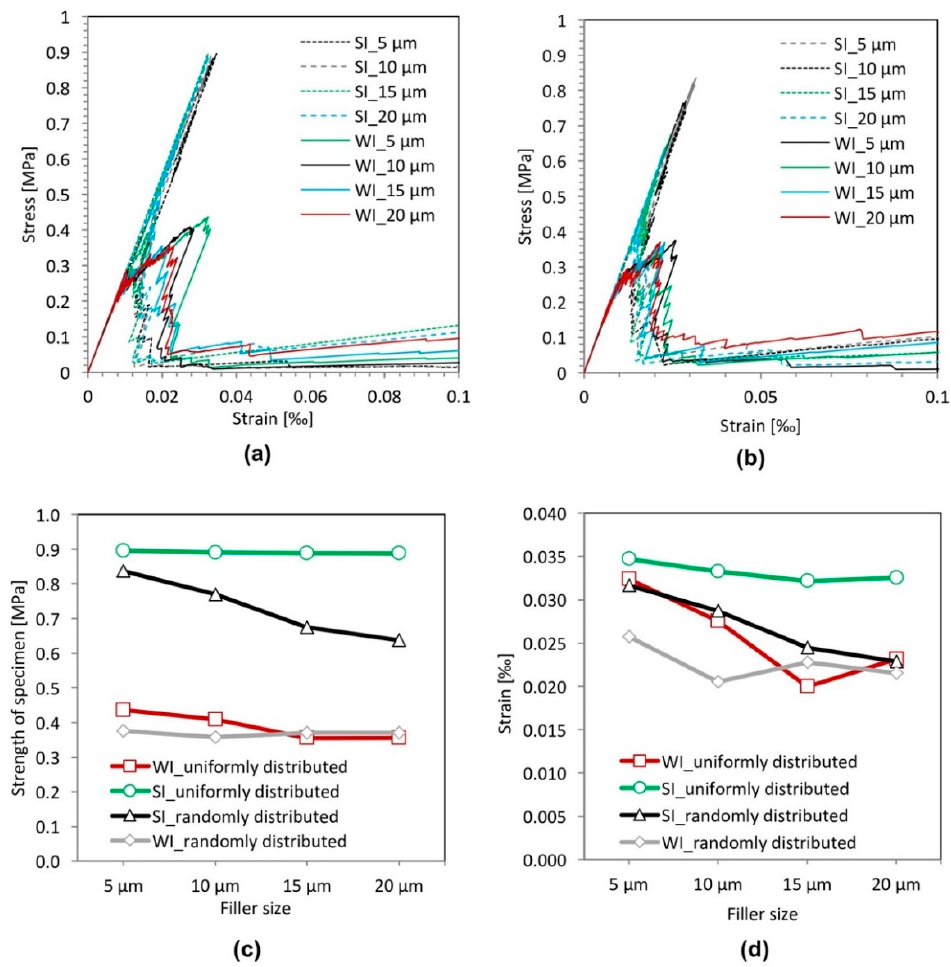
Figure 8. Simulated results of the filler size effect analyses for specimens with a strong interface (SI) and a weak interface (WI). ( a ) Stress-strain relation (uniformly distributed); ( b ) stress-strain relation (randomly distributed); ( c ) strength; ( d ) strain at peak stress.